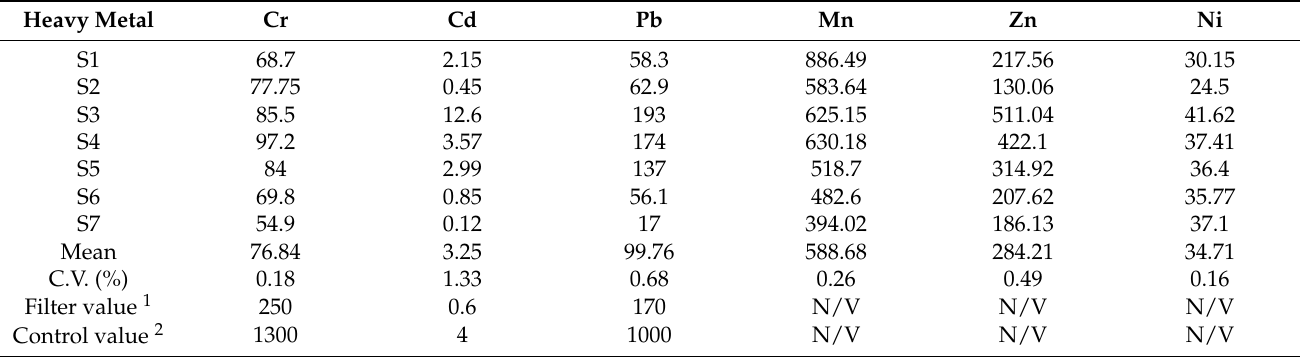
Table 5. Heavy-metal concentration (mg · kg − 1 ) in